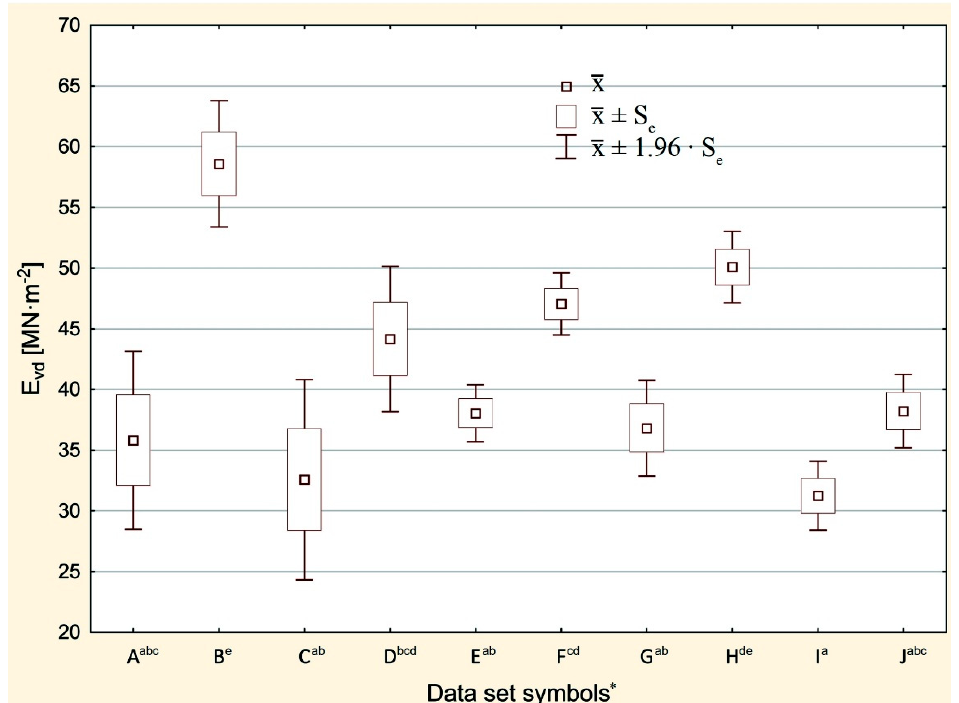
Key: DSS—data set symbol, N—number of measurements; E vd —dynamic deformation modulus; x(cid:3364) , x min , x max —mean, minimum and maximum values; SD—standard deviation; z p —coefficient of variation; s/v—ratio of mean plate settlement to settlement velocity, *—DSS marked with the same letters do not differ significantly—Tukey test for different N ( α = 0.05).